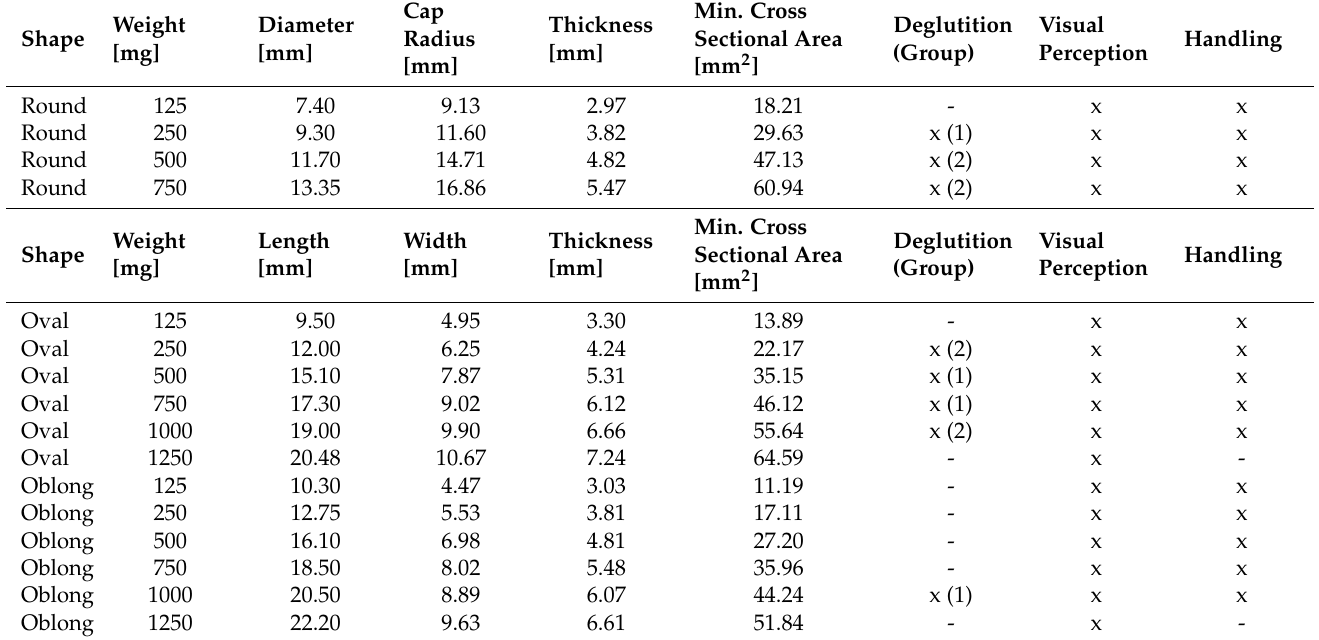
Table 1. Description of tablet characteristics. The inclusion of the tablets in different parts of the study is specified under “deglutition”, “visual perception”, and “handling”. The group for the deglutition part refers to the experimental group assignment.